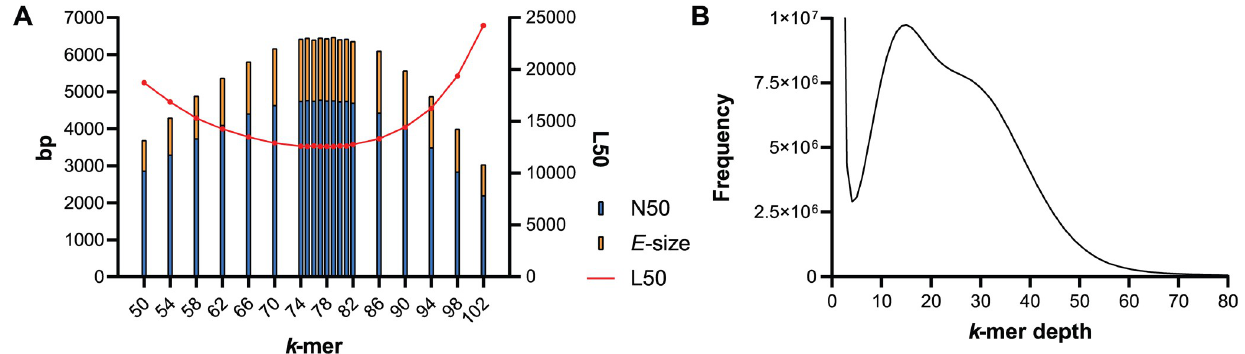
Fig 1. Analyses of k -mers in the Cardicola forsteri short-read library. (A) Contiguity statistics for the short-read assembly of different k -mers. N50 and E - size are shown as an overlaid column graph, while L50 is shown as an overlaid line graph with a secondary y -axis. (B) Plot of k -mer depth using the optimal k -mer